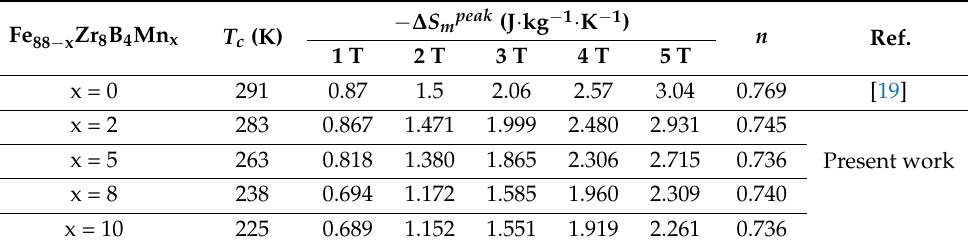
Table 2. Magnetic and magnetocaloric properties of Fe 88 − x Zr 8 B 4 Mn x amorphous samples.